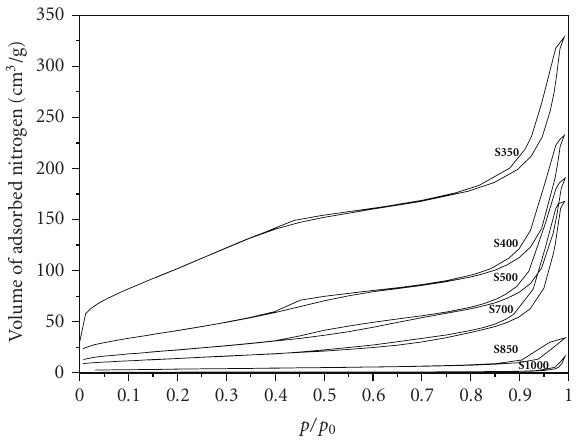
Figure 2: The nitrogen adsorption-desorption isotherms of the indicated samples.